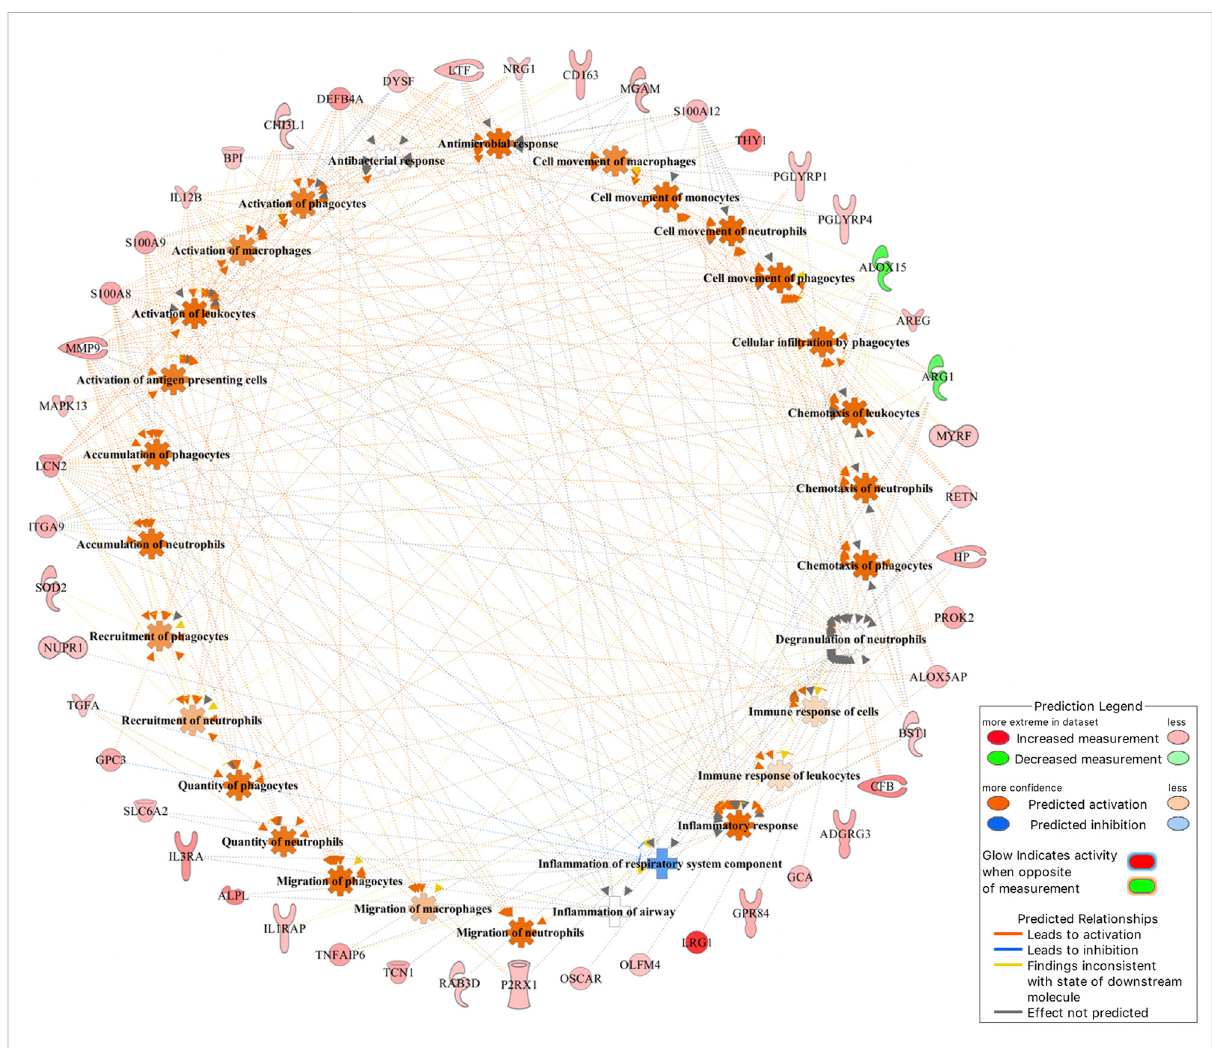
FIGURE 2 The in fl ammatory response was identi fi ed as the most signi fi cant ( p -value < 0.05) immune-related function that DE genes were involved